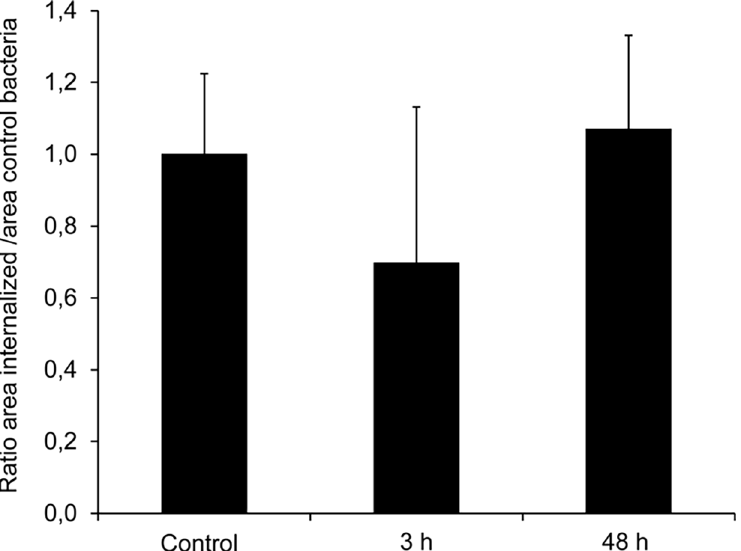
Fig 1. Single Reaction Monitoring (SRM) of BP0414 (MgtC). Relative abundance of BP0414 in extracellular bacteria (control), intracellular bacteria recovered 3 h post-infection (3 h), and intracellular bacteria recovered 48 h post- infection (48 h) are shown. Two independent biological replicates with two technical replicates each were analyzed. Values are expressed as ratios relative to the control. Data represent mean relative protein levels ±